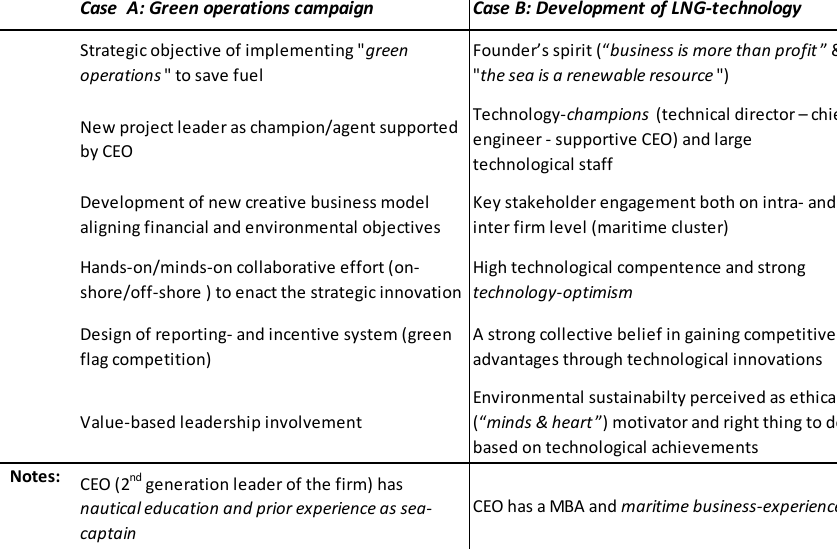
Table 2 . Key drivers and activities during the innovation